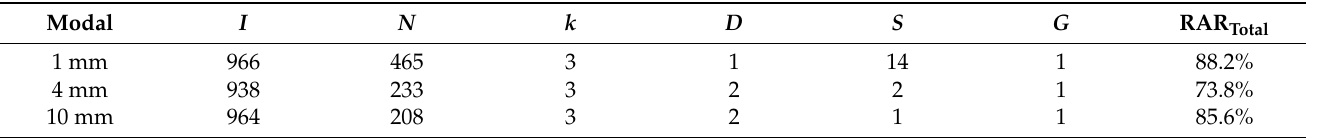
Table 4. Modeling discrimination effects of the optimal MW-kNN models processed by optimal NDF parameters.